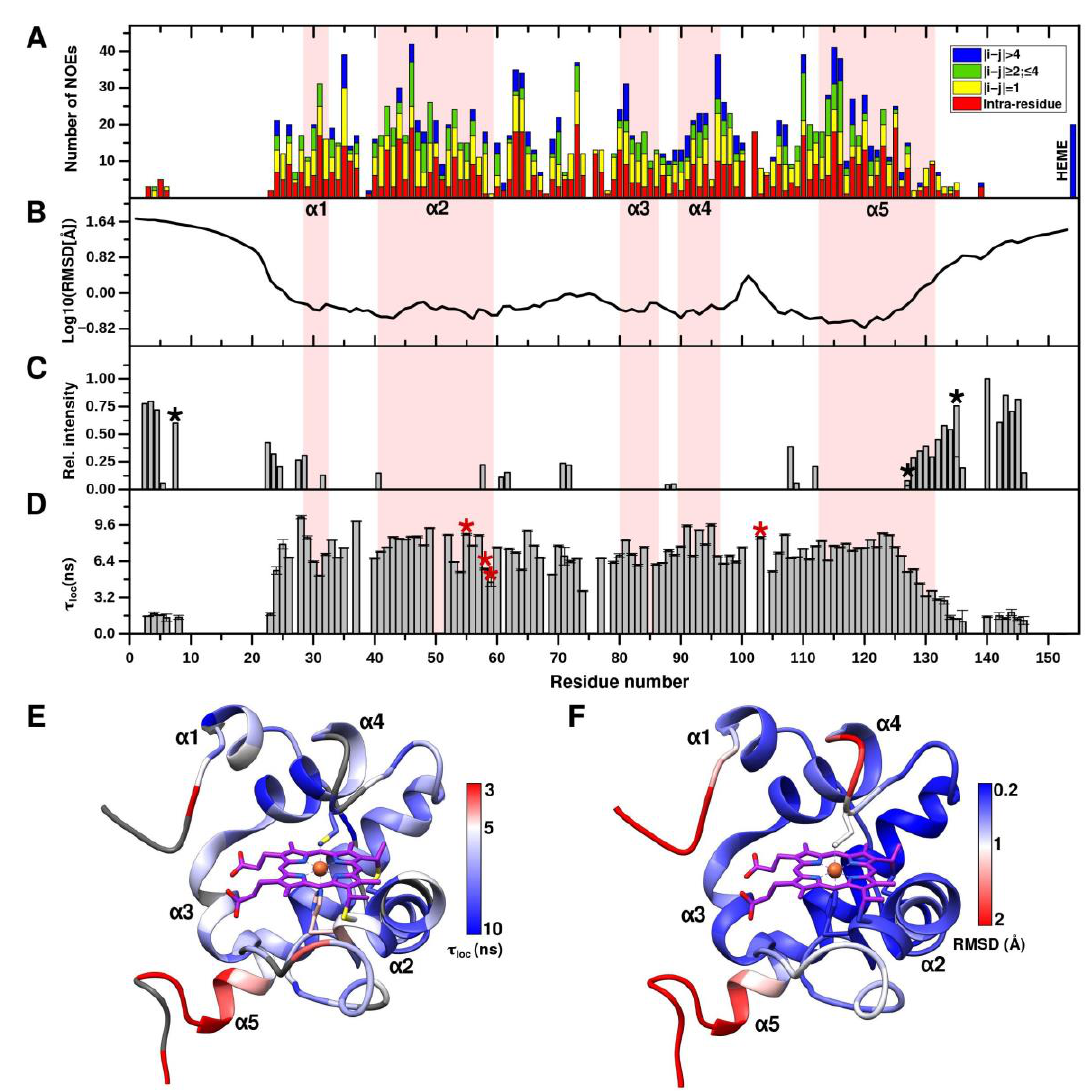
Figure 4 . Summary of NMR structural and dynamical parameters of CytC552. ( A ) Distribution of NOE restraints used in structure calculation along the CytC552 amino acid sequence. ( B ) Heavy atoms RMSD plot for NMR ensemble of CytC552. ( C ) Intensities of cross-peaks of the residual amide groups from 2D 1 H/ 15 N spectrum of CLEANEX experiment. Side-chain NH 2 groups are marked by black asterisks. ( D ) Distribution of local rotation correlation times ( τ loc ) of the CytC552 residues amide groups estimated from 15 N CSA/dipolar cross-correlated transverse relaxation experiment. The heme-ligating and axial heme-coordinating residues Cys55/Cys58 and His59/Met103, respectively, are marked by red asterisks. ( E , F ) CytC552 ribbon representation color-codded according to the τ loc and RMSD values,